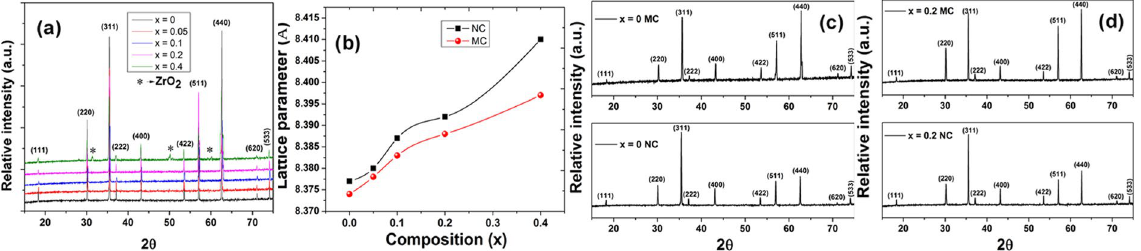
Figure 1. ( a ) X-ray diffraction spectra of sintered Co 1 + x Zr x Fe 2 − 2x O 4 (0 ≤ × ≤ 0.4)-MC samples; ( b ) The variation of lattice parameter as a function of Zr substitution, x and their comparison with normal compacted samples; ( c ) and ( d ) XRD patterns of NC and MC x = 0 and 0.2